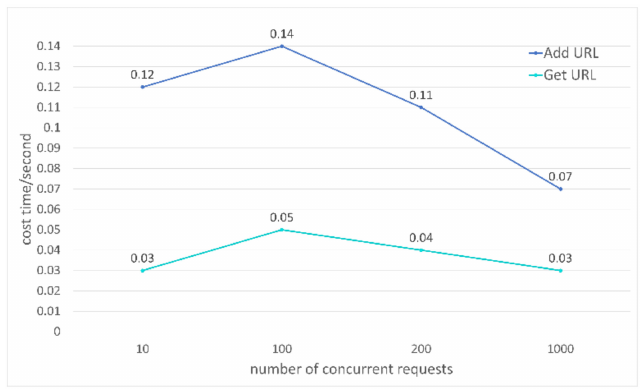
Figure 22. Time cost of Device Contract (DC).